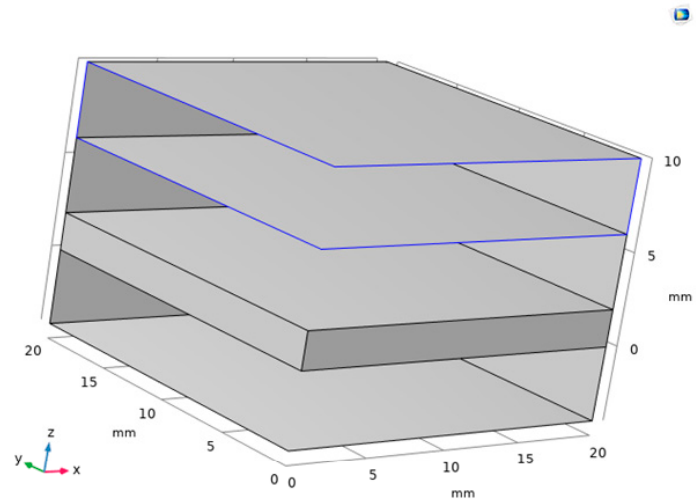
Figure 16. Traditional copper electrode plate model.